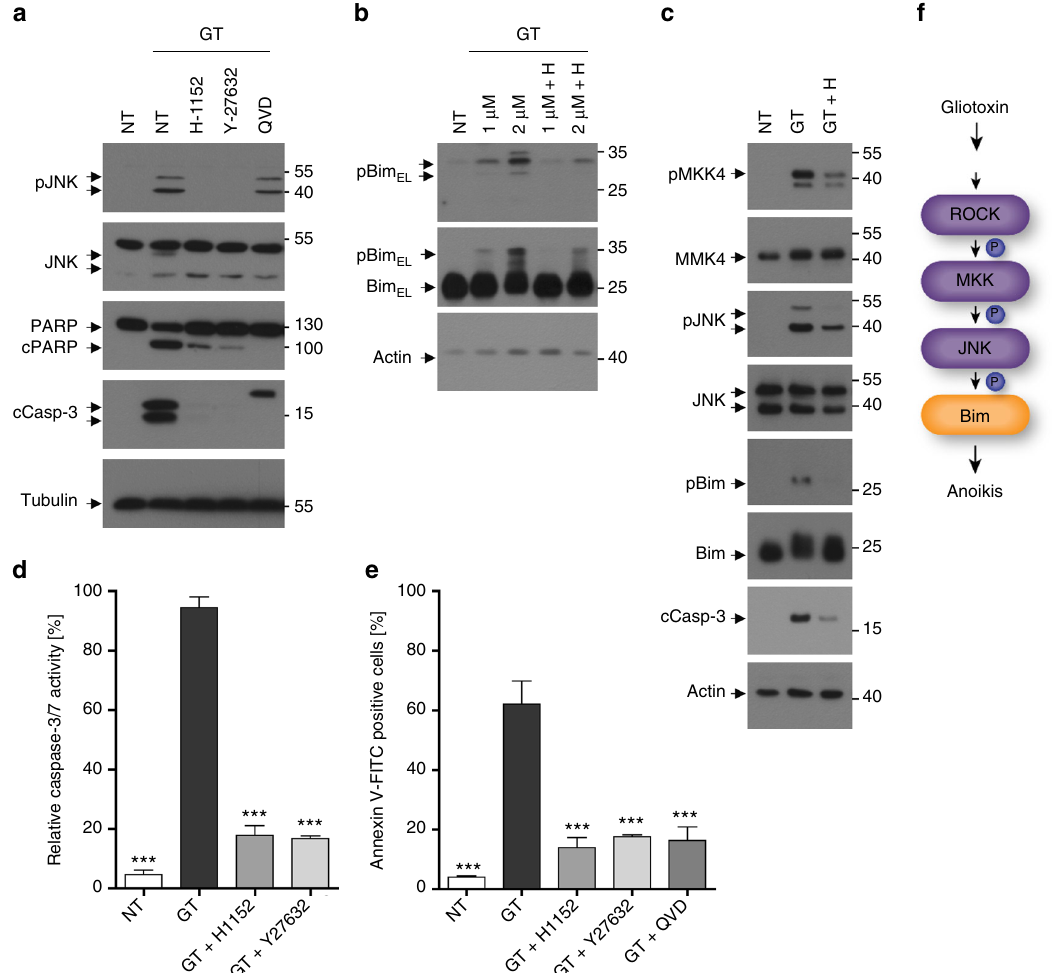
Fig. 2 ROCK is required for GT-induced anoikis. a , b Western blot analysis showing that the pre-treatment of BEAS-2B cells with the ROCK inhibitors H-1152 (1 µ M) or Y-27632 (1 µ M) abrogated GT-induced JNK phosphorylation and caspase-3 and PARP processing ( a ) as well as Bim phosphorylation ( b ). Treatment with 25 µ M QVD prevented caspase-3 and PARP processing but not JNK phosphorylation. c Western blot analysis showing that the pre-treatment of MEFs with the ROCK inhibitor H-1152 diminished GT-induced MKK4 and JNK phosphorylation, Bim phosphorylation and caspase-3 processing. d , e Both ROCK inhibitors prevented GT-induced caspase-3/7 activity ( d ) and apoptosis (as measured by annexin V-FITC staining) ( e ) in MEFs to the same extent as the general caspase inhibitor QVD (25 µ M). f Schematic representation of how GT activates ROCK and triggers a MKK4/MKK7- JNK-Bim-mediated anoikis signalling pathway. Tubulin ( a ) and actin ( b , c ) were used as loading controls. Graphs in d and e show the means of at least three independent experiments ± s.e.m.; p -values: ***<0.001, one-way ANOVA, post hoc: Bonferroni compared to